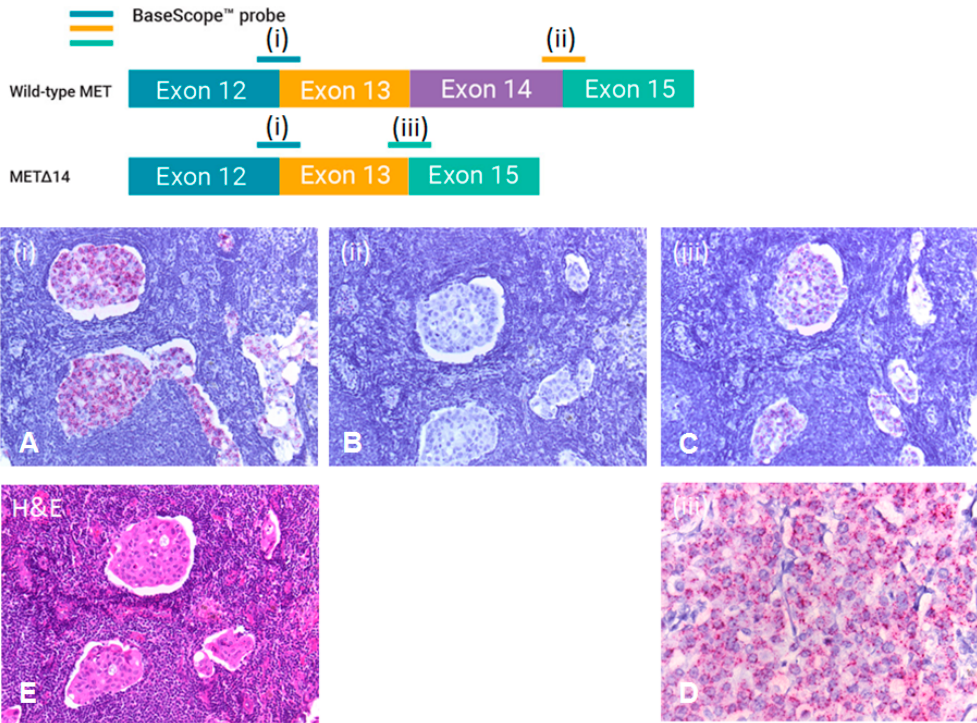
Figure 3. RISH analysis. Probe design for the detection of METex14 using the ACDbio BaseScope™ assay. One probe (blue — (i)), designed to detect the junction between exons 12 and 13, is considered common and can detect both wild ‐ type MET and METex14 mRNA. A second probe (orange) is designed to detect the junction between exons 14 and 15 (ii) and detects only MET mRNA containing exon 14 (wild ‐ type MET). A third probe is designed to detect the junction between exons 13 and 15 (iii) and detects only METex14 skipped mRNA (METex14). The three probes are tested in parallel. An example of RISH on a patient sample using these probes demonstrating the presence of METex14 skipping. 20× magnification of (Panel A ) exon 12/13 probe (detects all MET); (Panel B ) exon 14/15 probe (detects wild ‐ type MET); (Panel C ) exon 13/15 probe (detects (METex14)). In this example, almost the entire sample demonstrates METex14. (Panel D ) 40 × magnification of the (iii) exon 13/15 probe (METex14), while (Panel E ) is a H&E stain from the same